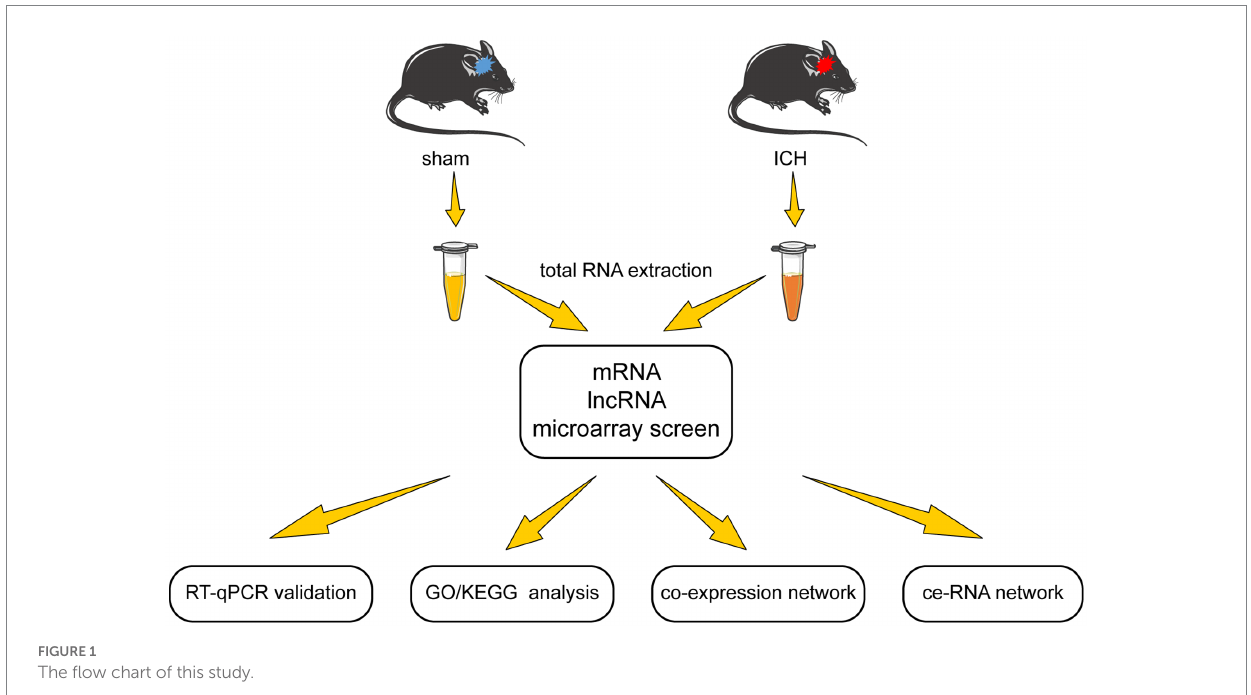
FIGURE 1 The flow chart of this